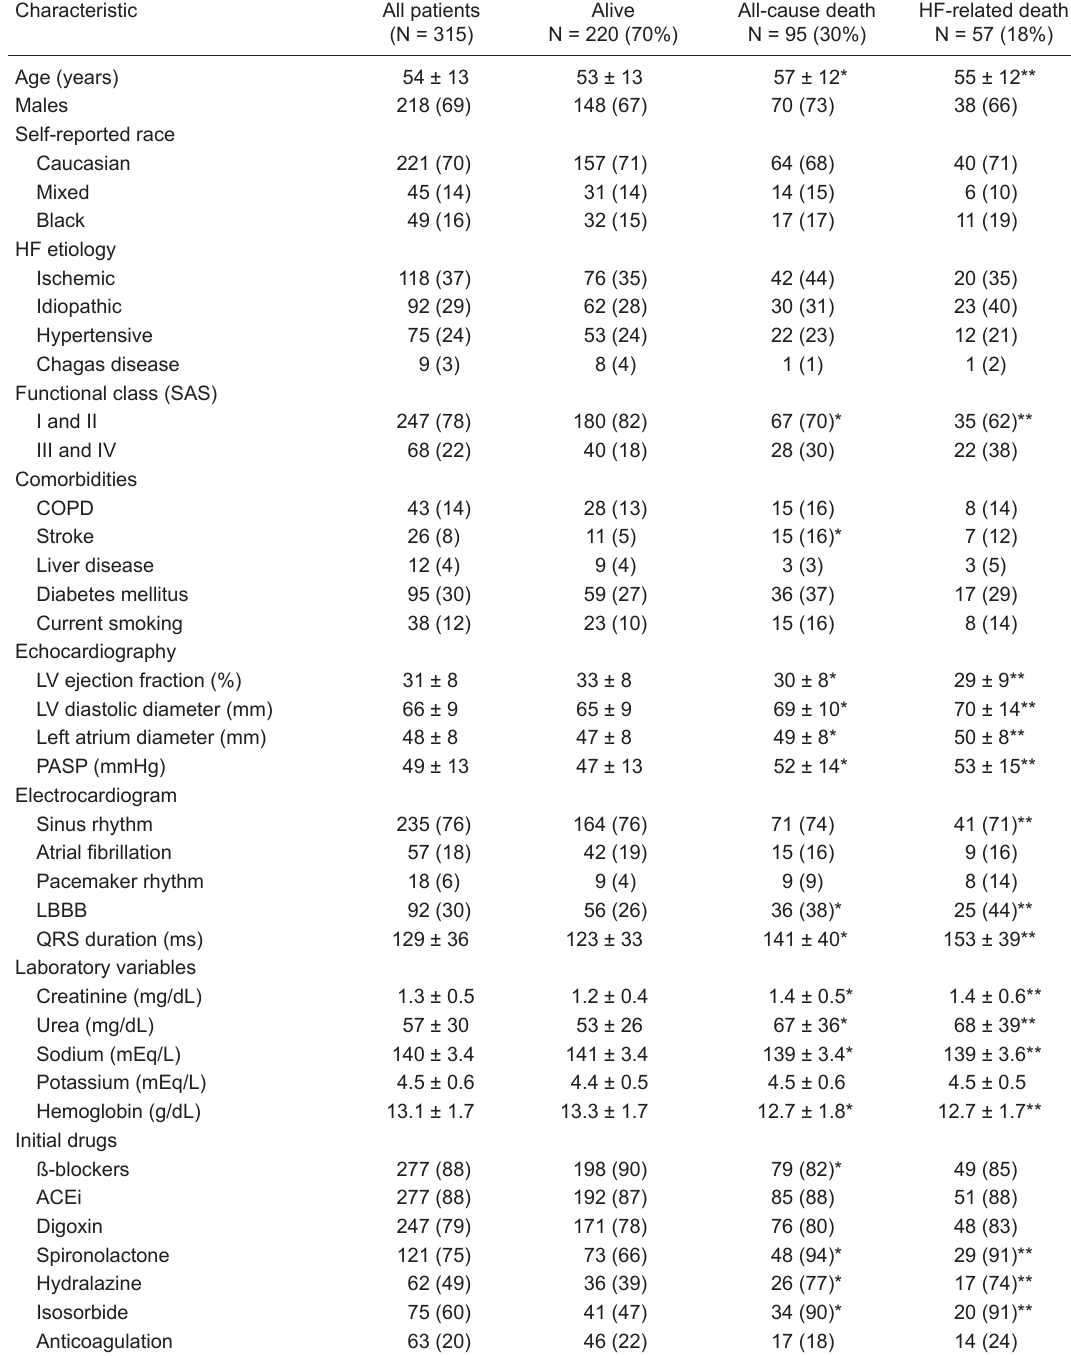
Table 1. Baseline clinical characteristics of 315 heart failure (HF)